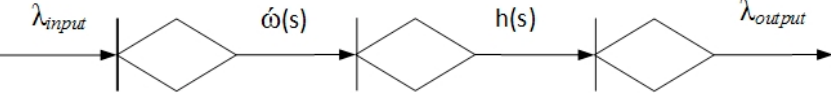
Figure 4. Enlarged stochastic network of the packet delivery process.